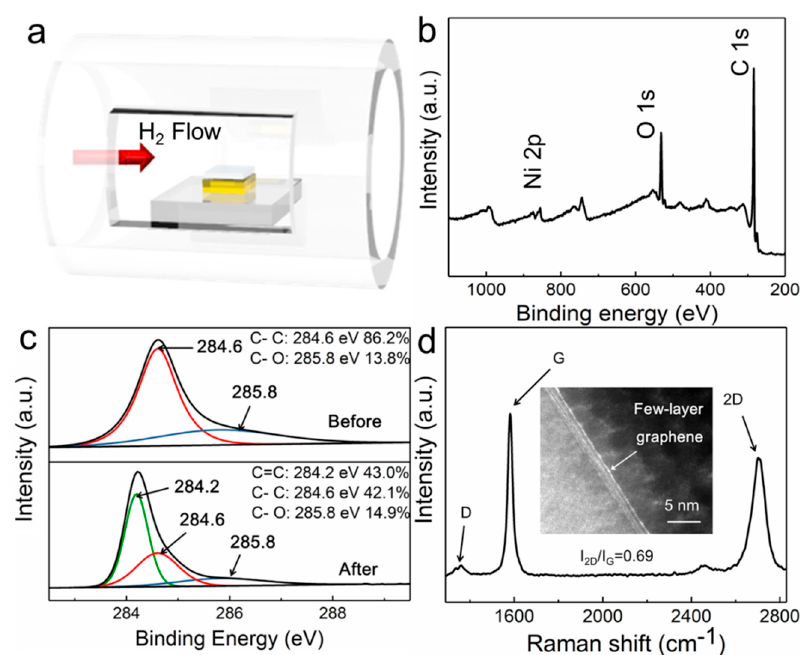
Figure 1. ( a ) The preparation process of Ni NPs-modified graphene–diamond hybrid electrodes. ( b ) X-ray photoelectron spectroscopy (XPS) survey scan and ( c ) high-resolution C1s spectra of the diamond surface before and after the catalytic annealing process. ( d ) Raman spectrum of the obtained composite electrodes. Inset of ( d ) TEM image of the hybrid electrode. Sensors 2019 , 19 , x FOR PEER REVIEW